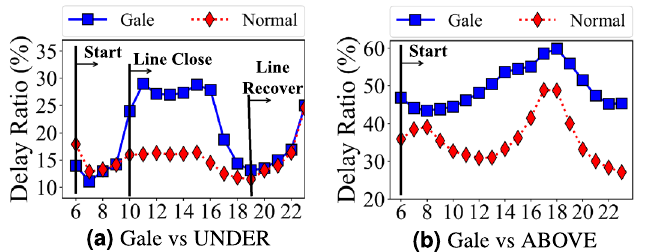
Figure 10. Extreme weather causes high travel delay in both underground and aboveground system; caused ( a ) subway lines close and ( b ) low speed on roads.